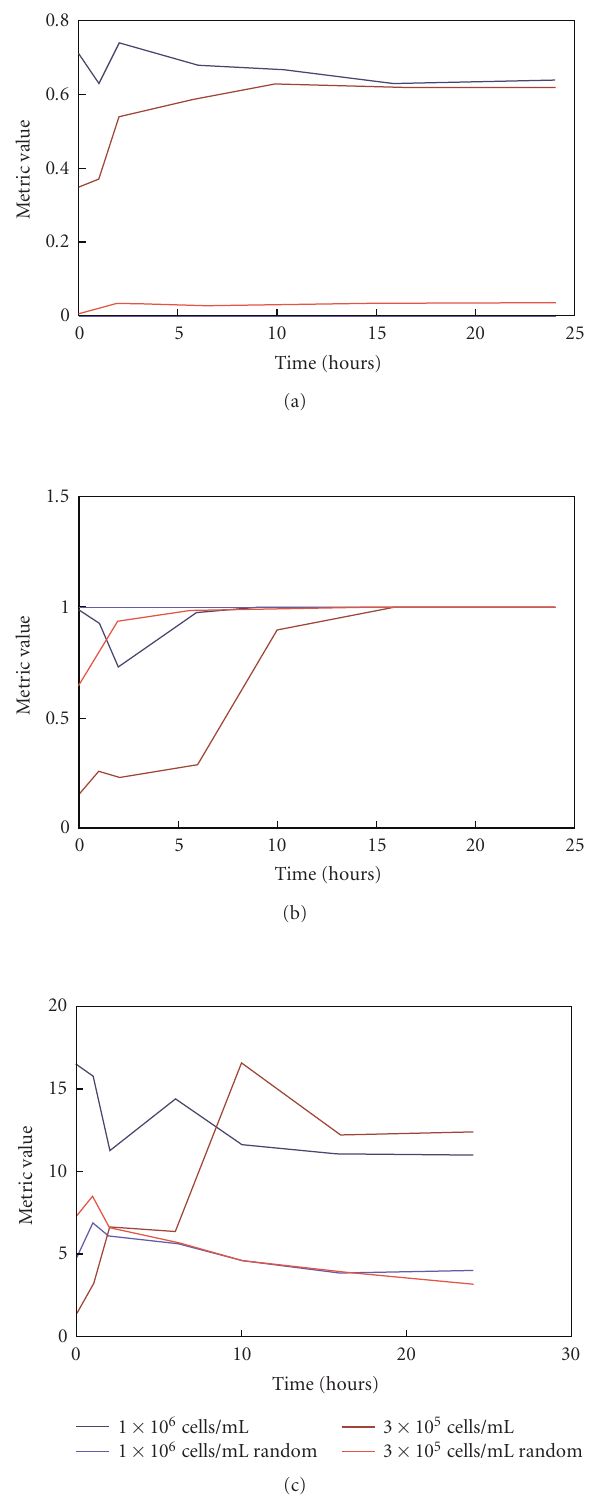
Figure 8: Cell-graph features are distinct from random graphs. Random graphs were generated keeping the number of nodes and links constant. Features were extracted from the random graphs and compared to features from cell-graphs to determine significance. (a) Clustering Coe ffi cient. (b) Giant Connected Component. (c) Average Eccentricity.